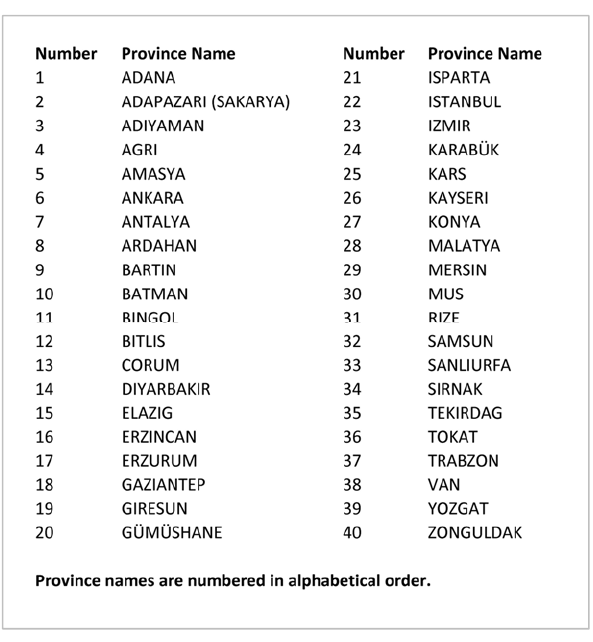
Figure A1. Province names numbered in Figure 2. Table A2. Hydrologic soil groups according to their major soil group classification